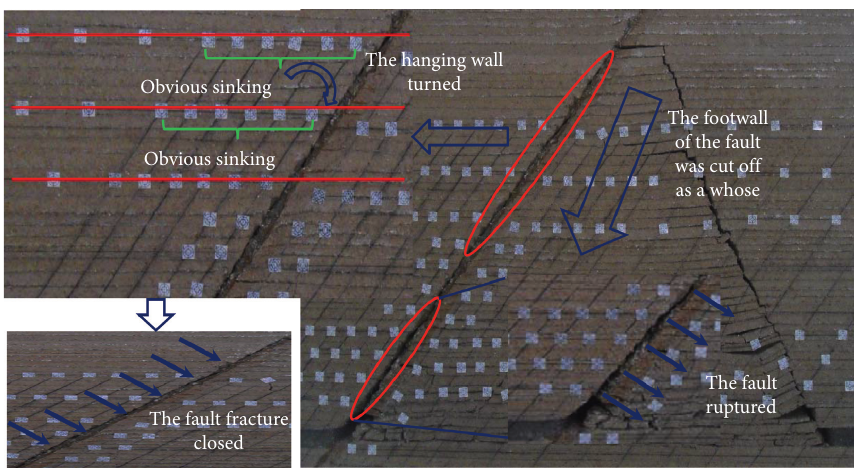
Figure 8: Overburden structure when the panel is mined to the